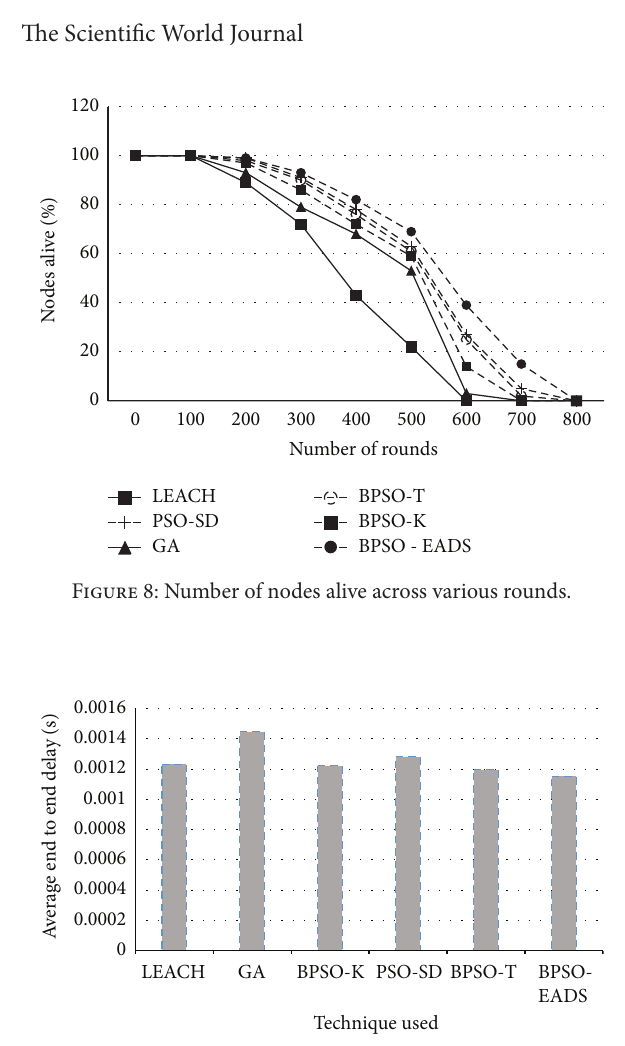
Figure 9: Average end to end delay over 500 rounds.